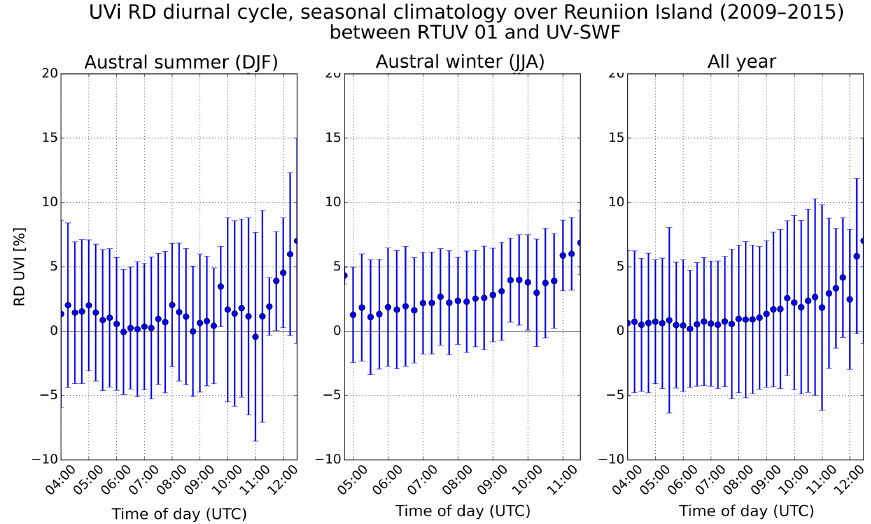
Figure 10. Diurnal cycle of UVI relative difference between RTUV01 and UV-SWF for austral winter, summer and all year. Climatological values of UVI relative differences obtained every 15min are in blue dots with dispersion bar ( ± 1 σ , standard deviation).